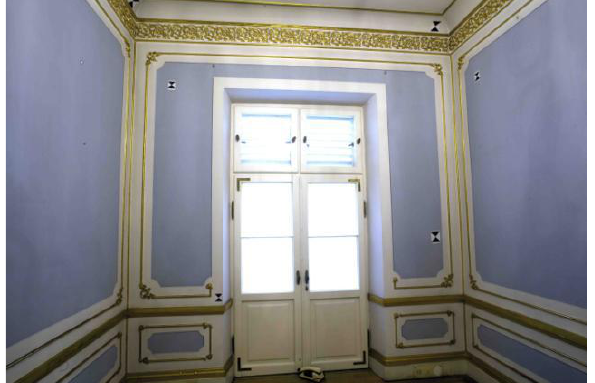
Figure 2. A section of the “Blue Chamber” at the Museum of King Jan III’s Palace at Wilanów (Warsaw,